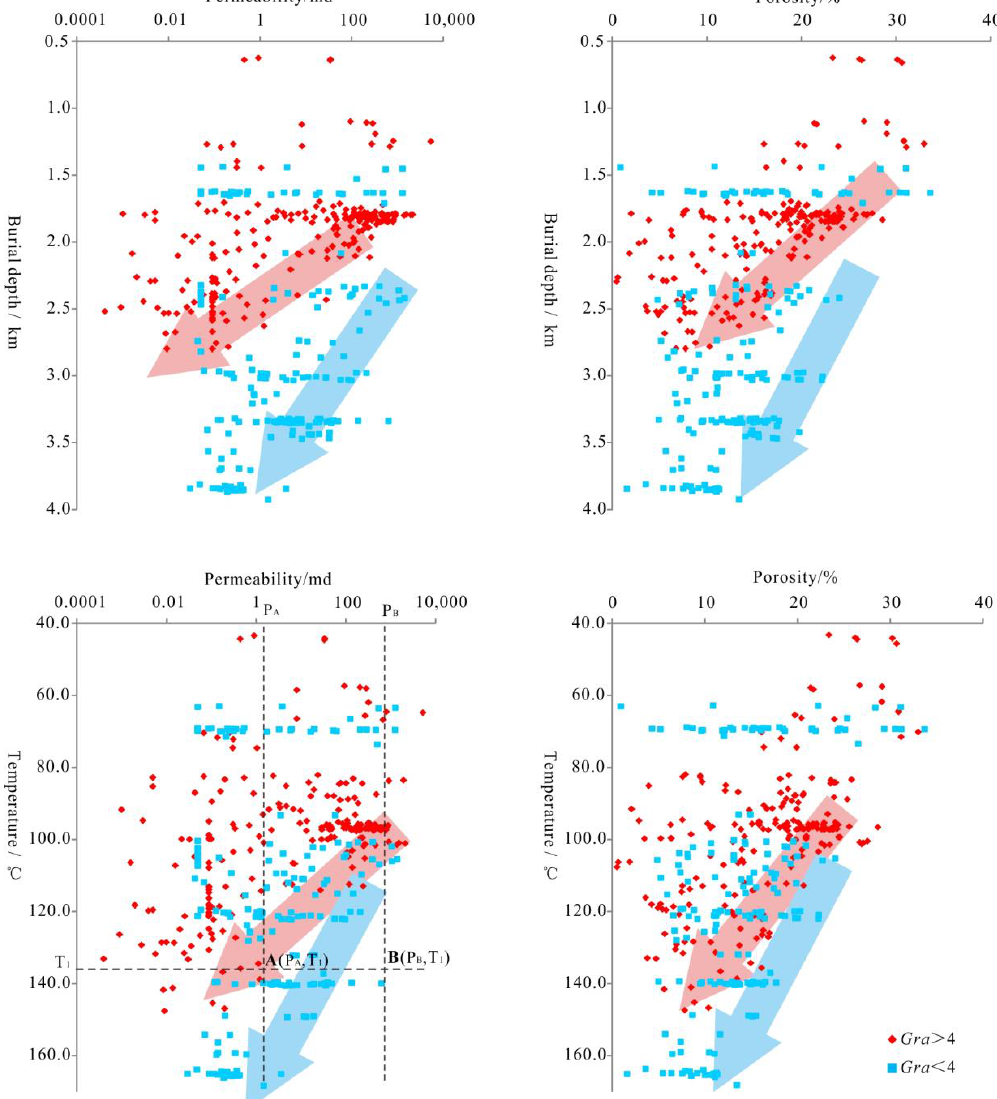
Figure 8. Different trends in porosity/permeability with burial depth/temperature in the high and low geothermal gradient areas.